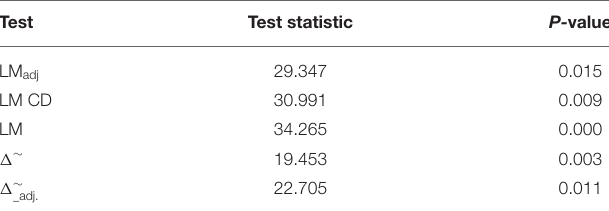
TABLE 3 | Results of cross-sectional dependence and heterogeneity tests.